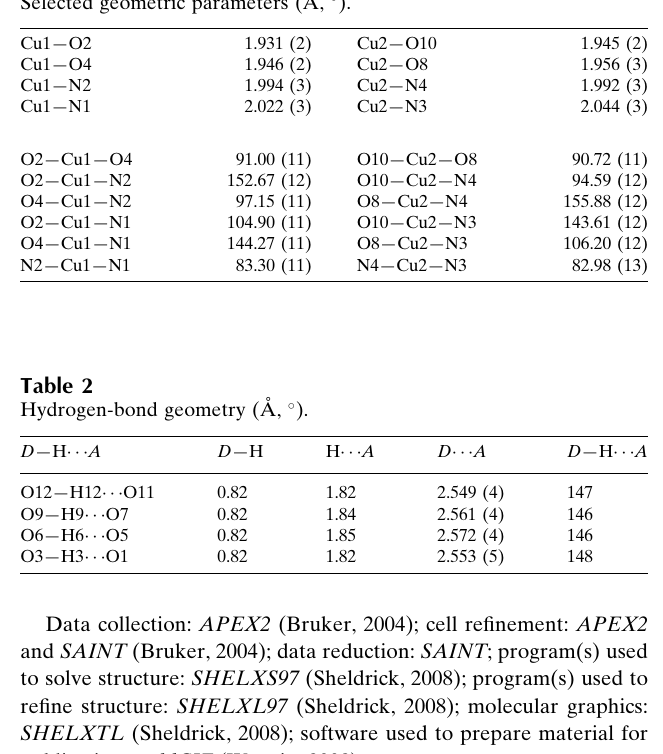
Selected geometric parameters (A˚ , (cid:1) ).